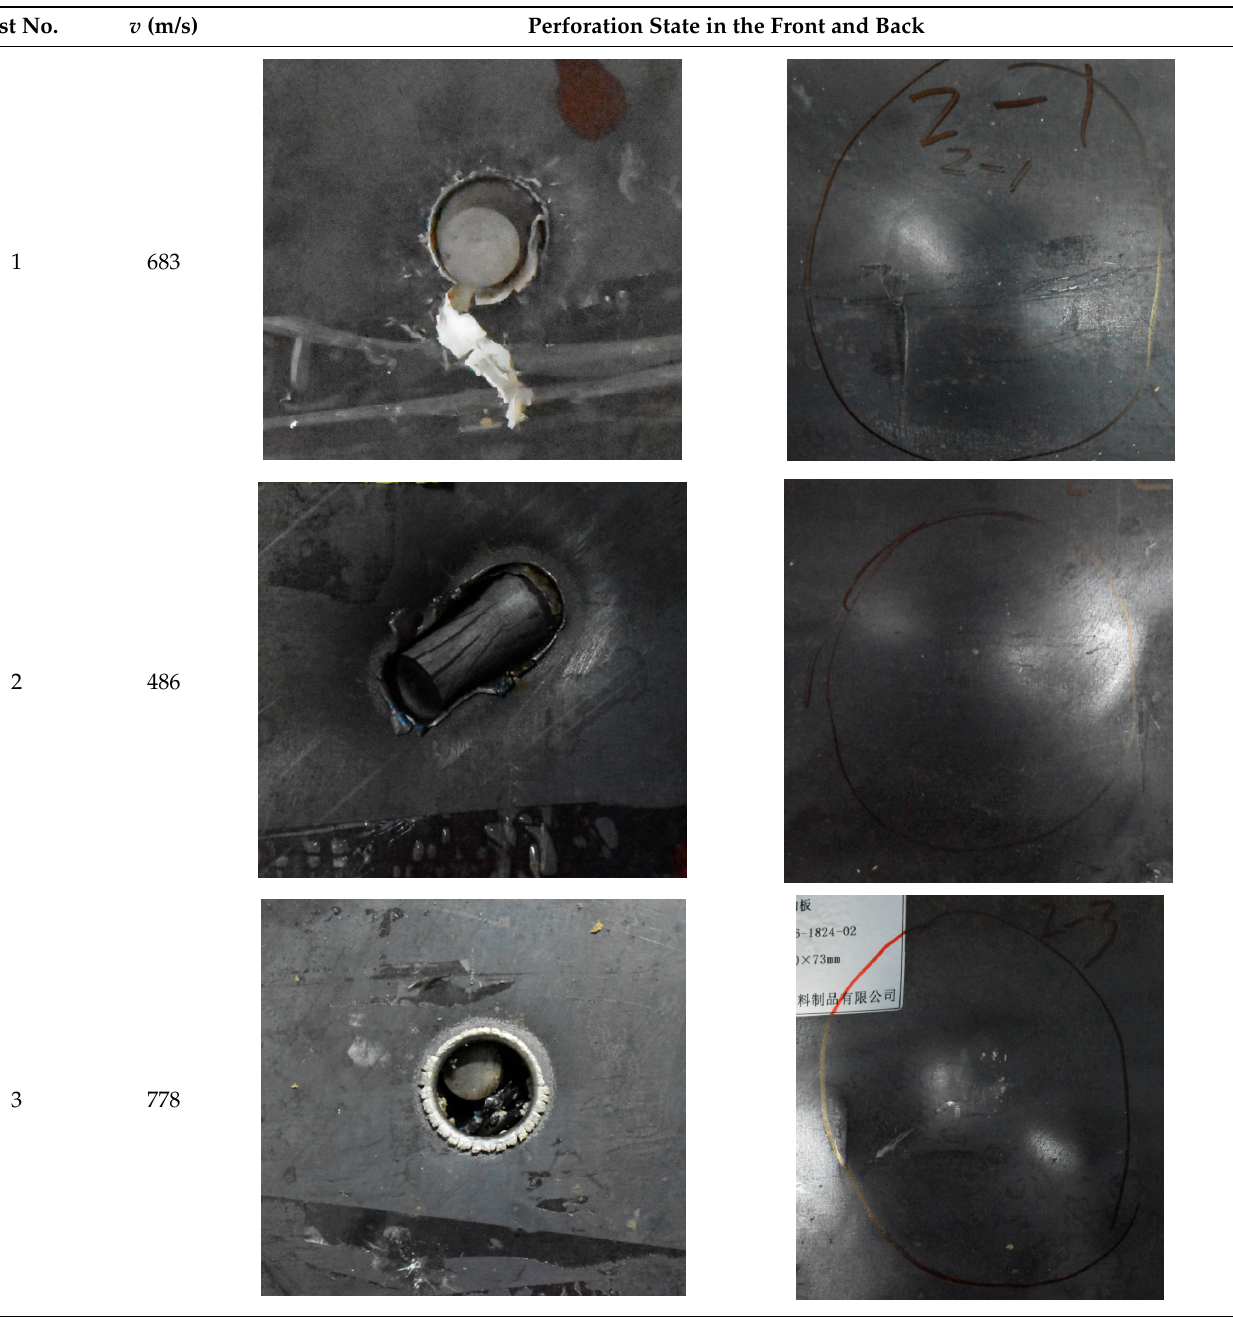
Figure 10. p–v curve of the blunt projectile penetration into the armor with two layers of PE. Table 11. Ballistic impact results of armor with three layers of PE.